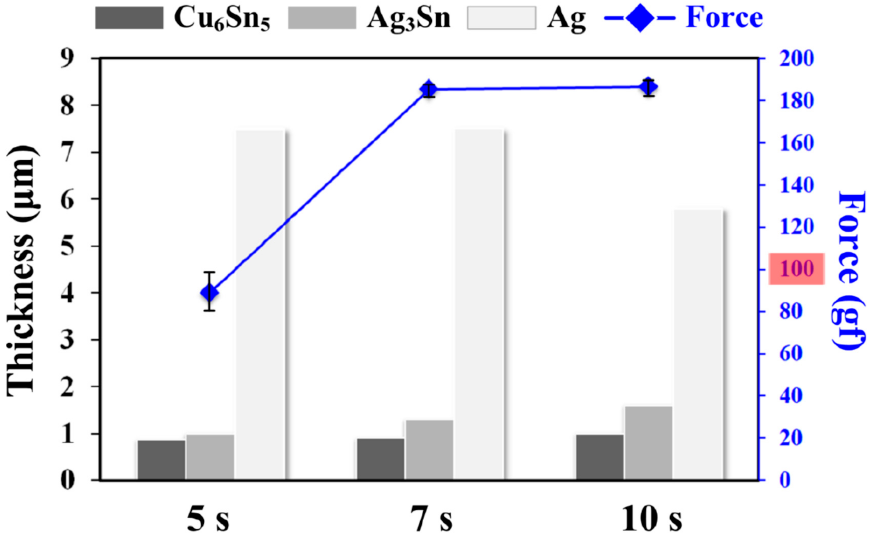
Figure 2. Intermetallic compounds (IMCs) thickness and peel strength of the Sn–0.7Cu–0.2Zn PV module as a function of reflow times.